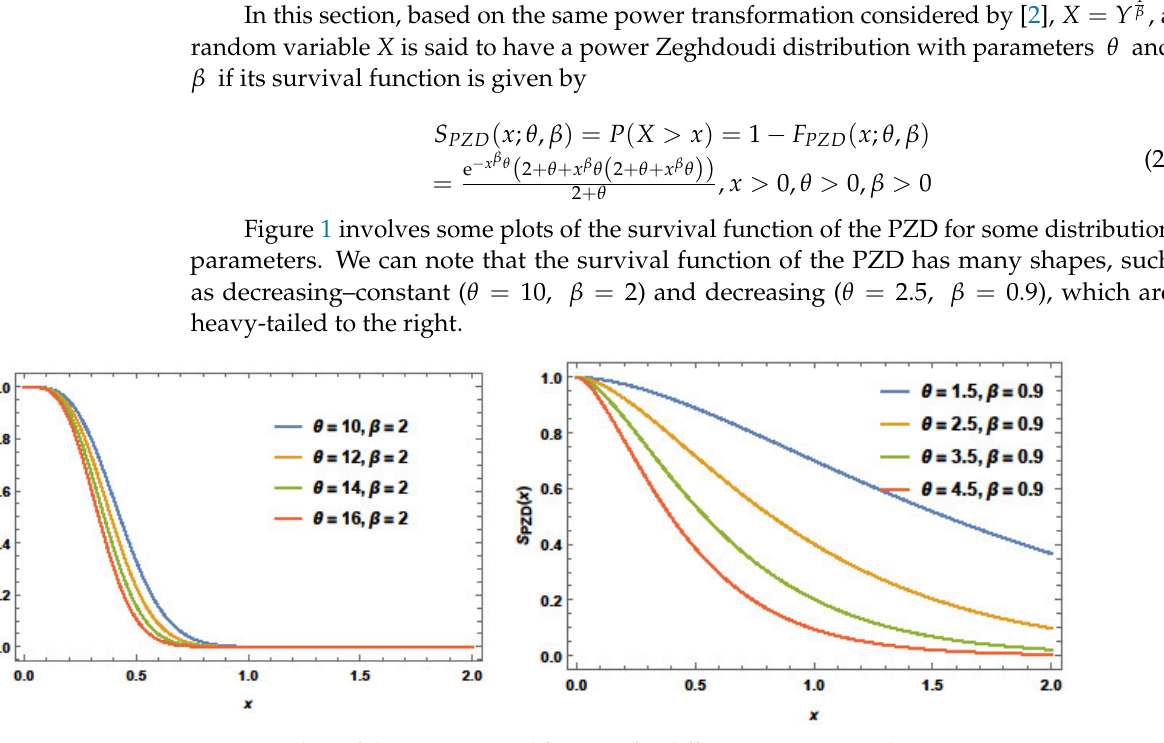
Figure 1. Plots of the PZD survival function for different parameter values.